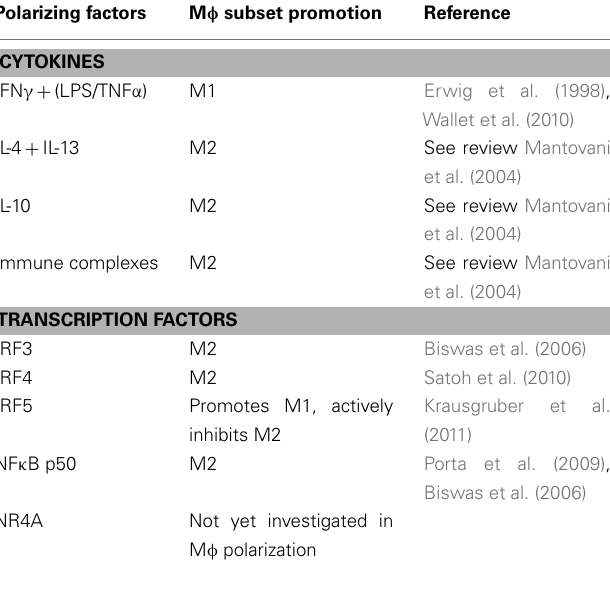
Table 1 | Description of the regulators in synovial inflammation that could potentially influence macrophage